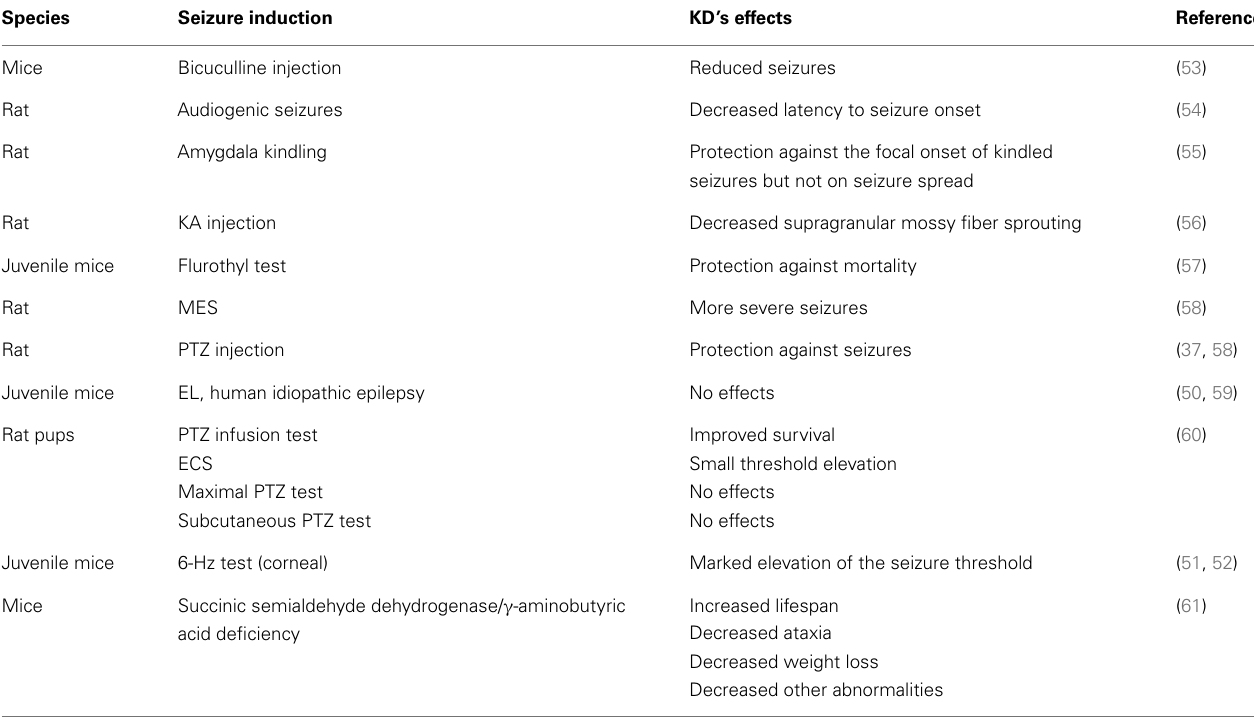
Table 2 | Effects of the ketogenic diet (KD) in seizure and epilepsy models